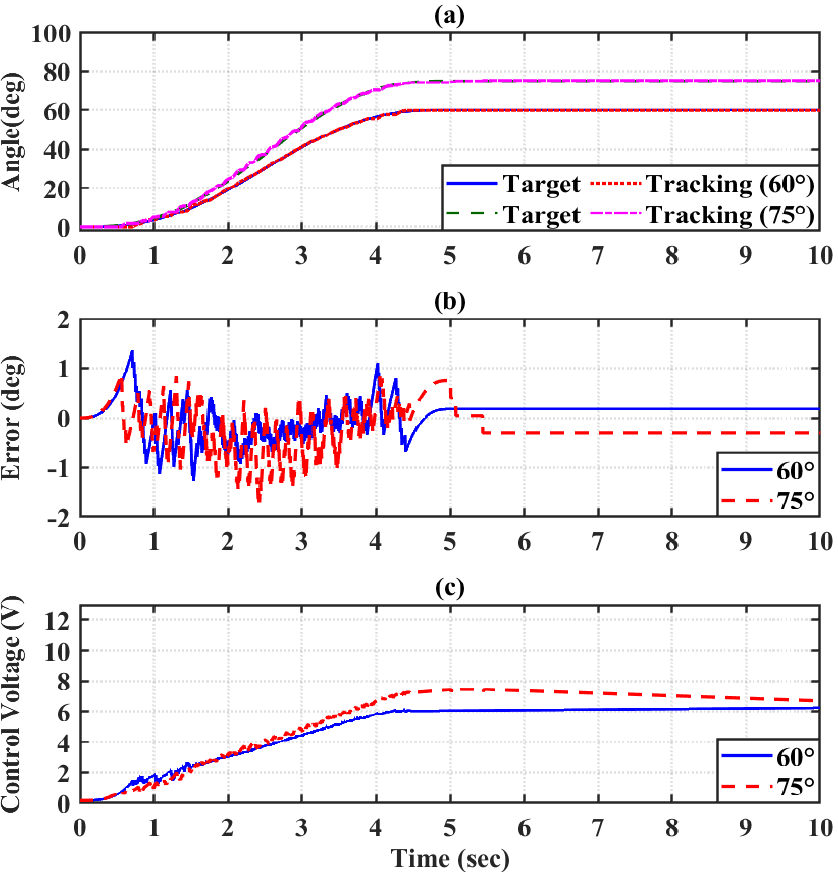
Figure 14. Results of fifth-order path-tracking for elbow joint flexion angles of 60° and 75°. ( a ) System response, ( b ) tracking error, and ( c ) control voltage.